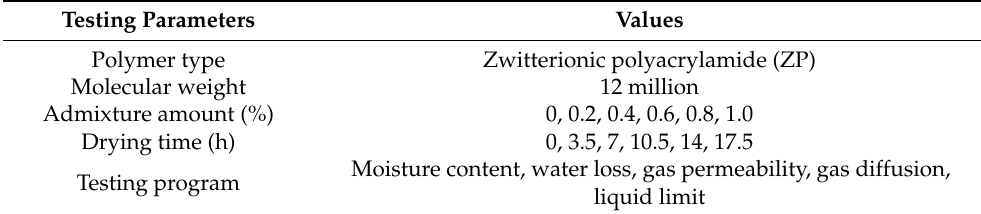
Table 2. Testing program and parameters of this